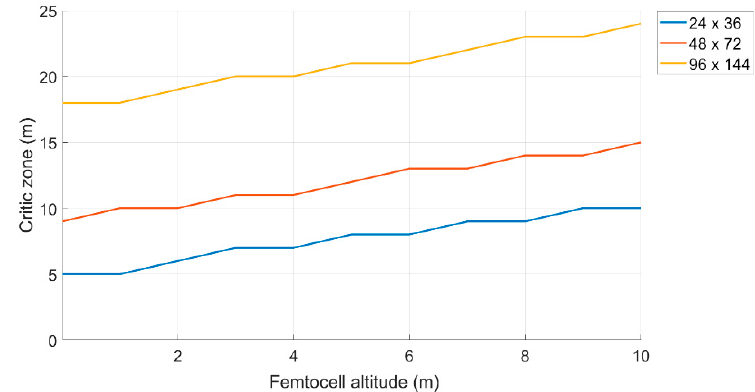
Figure 17. Variation of the “Critical Zone” to the increase of the femtocell altitude.